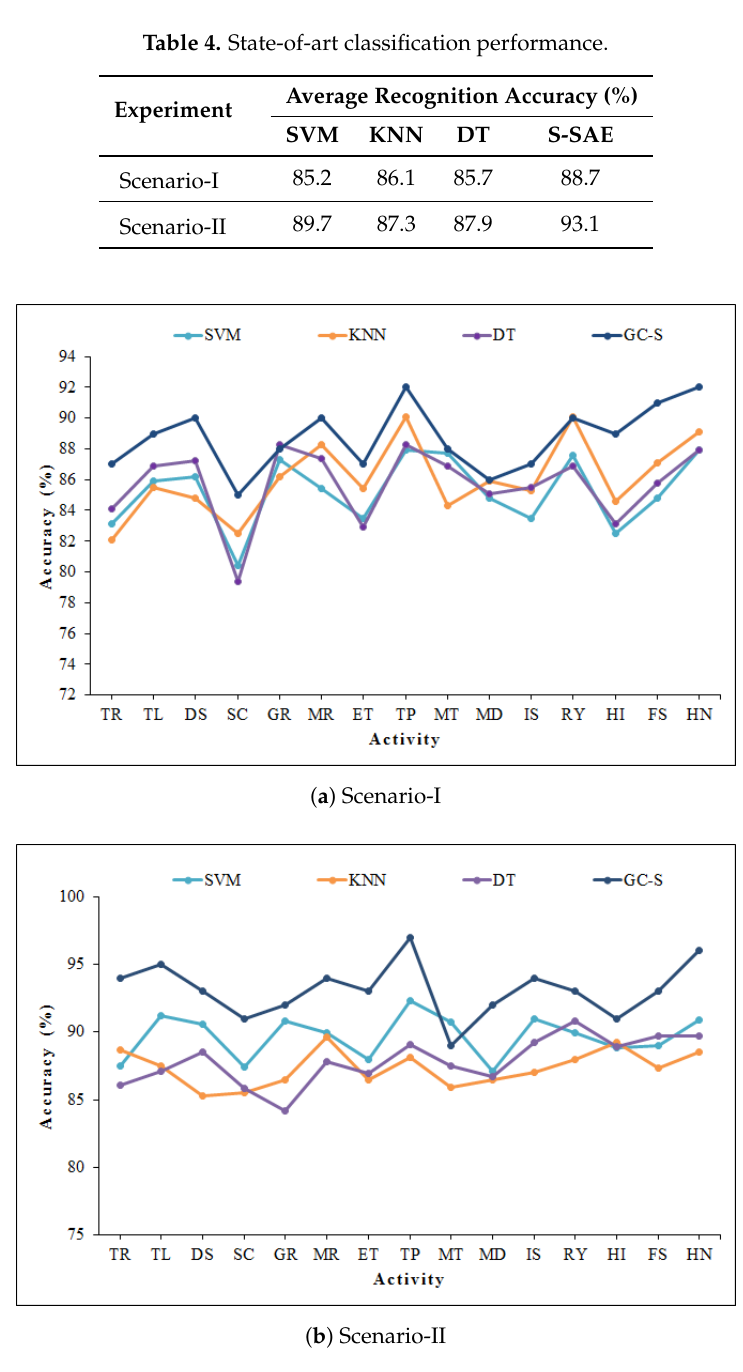
Figure 12. Classification performance of GC-based features with conventional